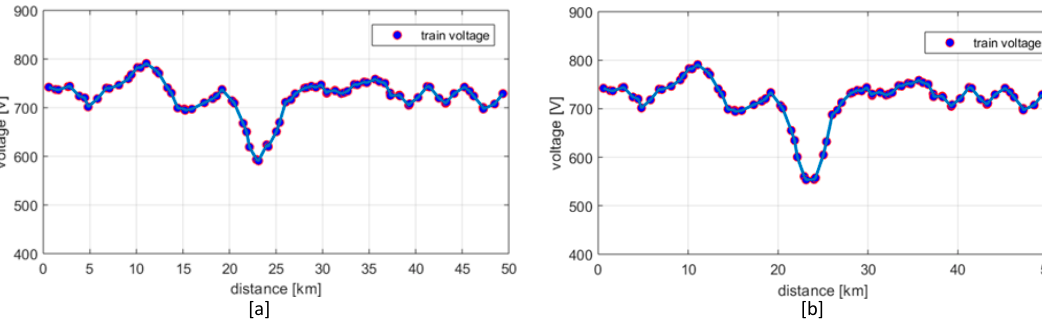
Figure 16. Train voltage against location: ( a ) Normal operation; ( b ) TPSS-13 is switched off.